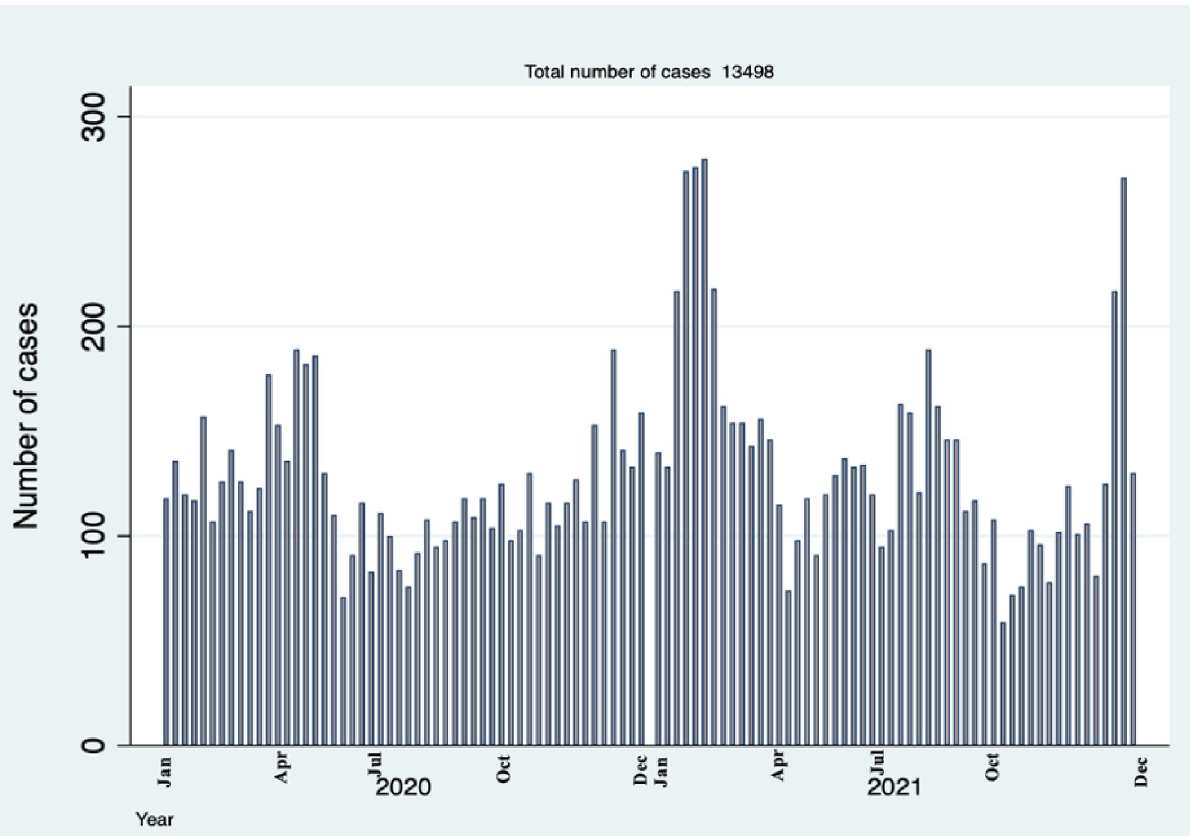
Fig 5. Number of pneumonias, URT and suspected COVID-19 cases attended in a Tanzanian National Hospital by